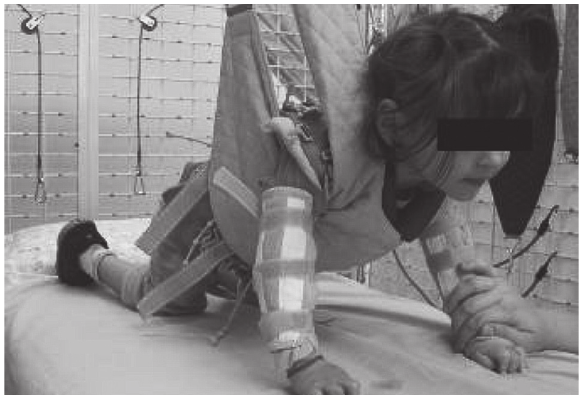
Figure 3 - Patient using the tracking rail in the monkey cage Source: Research data.